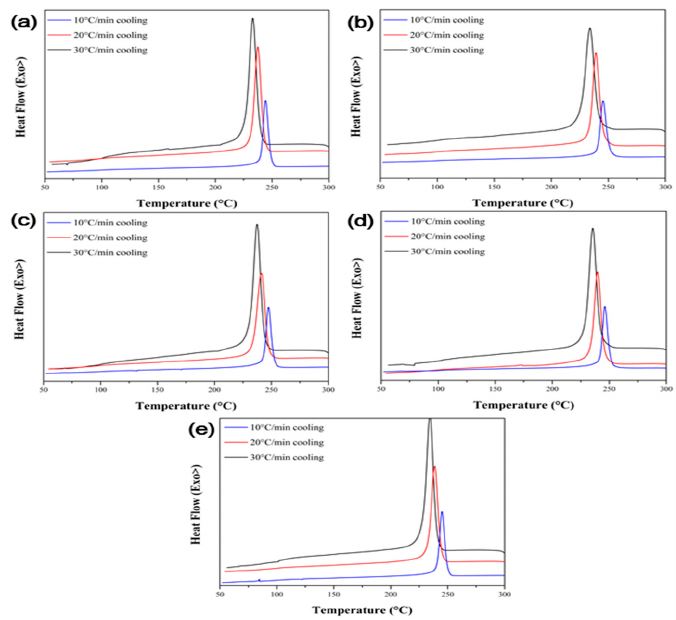
Figure 7. Non-isothermal crystallization cooling curve of the PPS/MWCNTs composites. ( a ) Neat PPS, ( b ) PPSP1, ( c ) PPSA1, ( d ) PPSHP1, and ( e ) PPSS1.